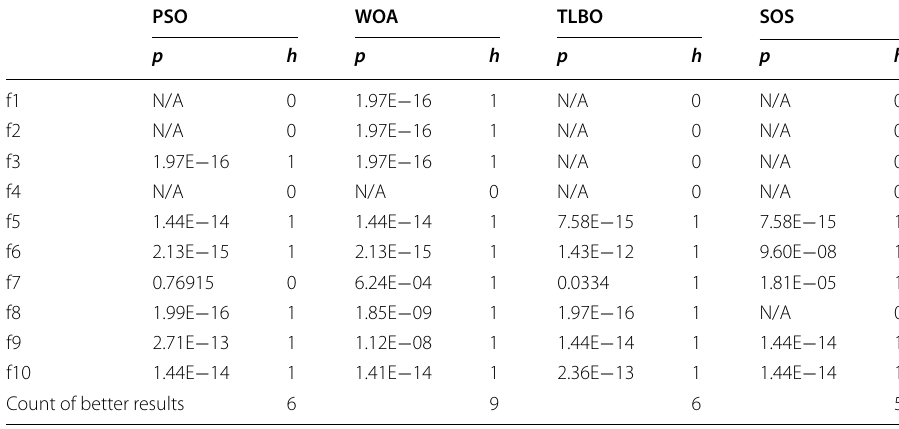
Table 4 Results of the Wilcoxon’s rank sum test for MASOS and other